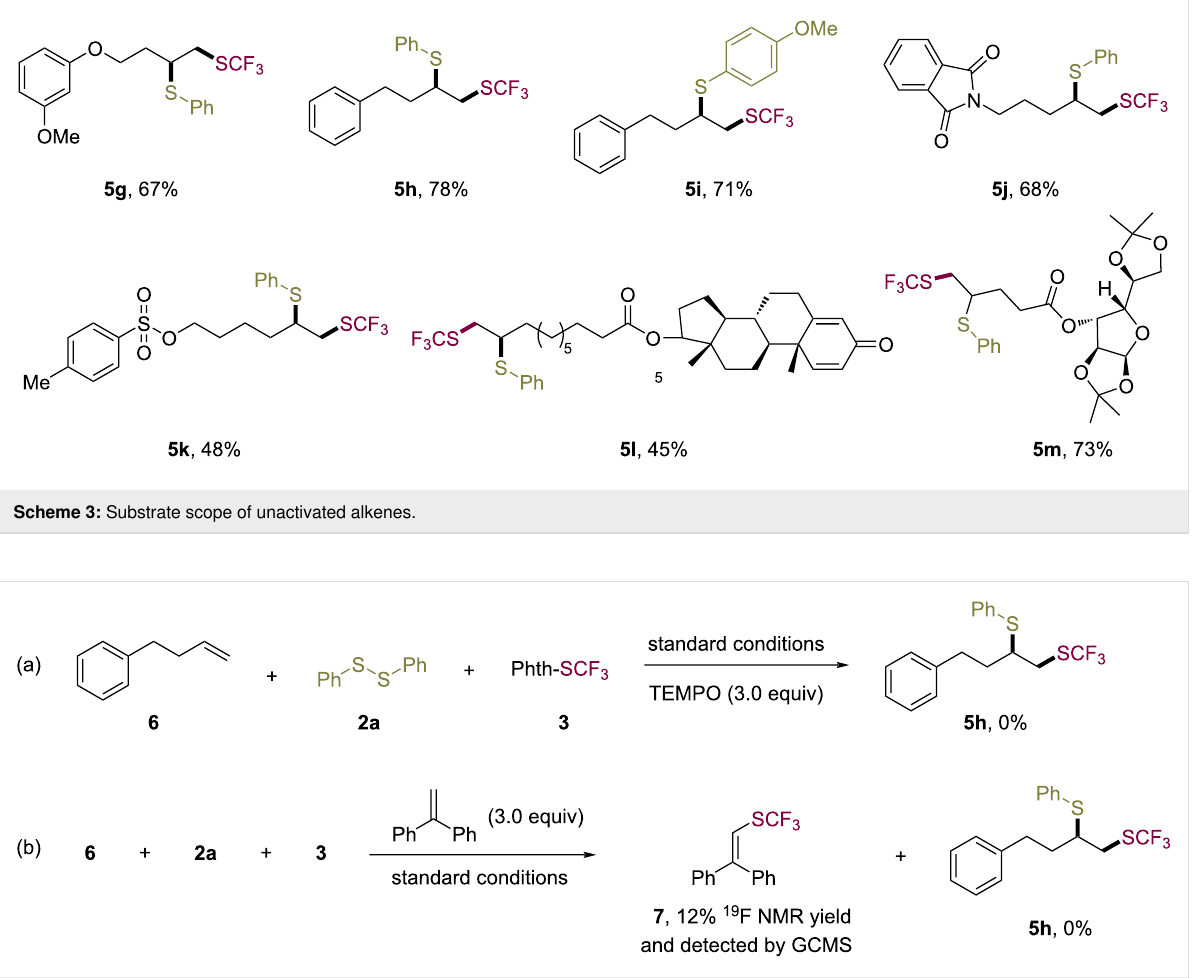
Scheme 4: Control